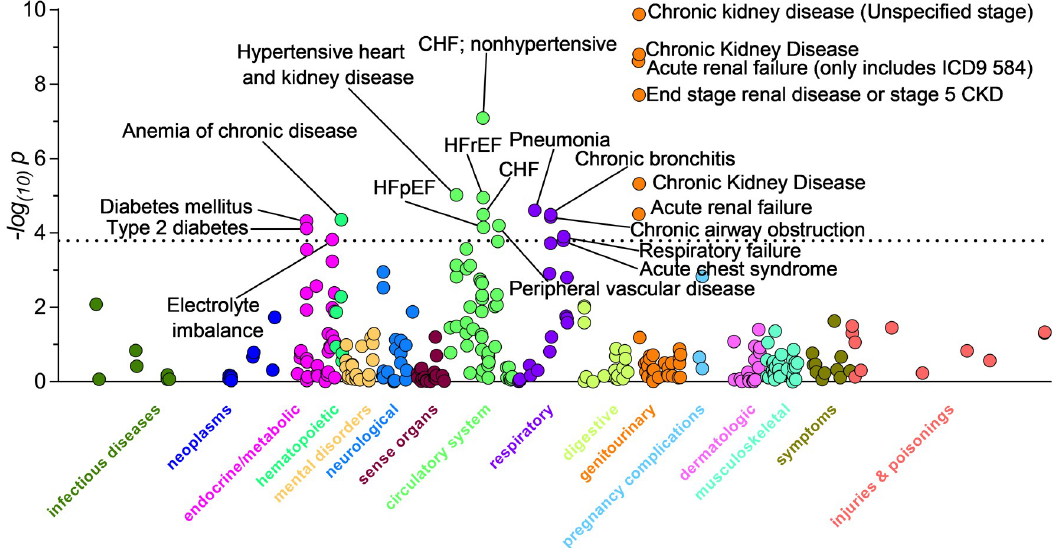
Fig 1. Manhattan plot for clinical phenotypes associated with COVID-19 hospitalization. Using a minimum case count of 20, we identified 313 clinical phenotypes, from PheCode Map 1.2, that could be used for these association studies. Dashed line denotes the Bonferroni significance (1.60X10 -4 ).